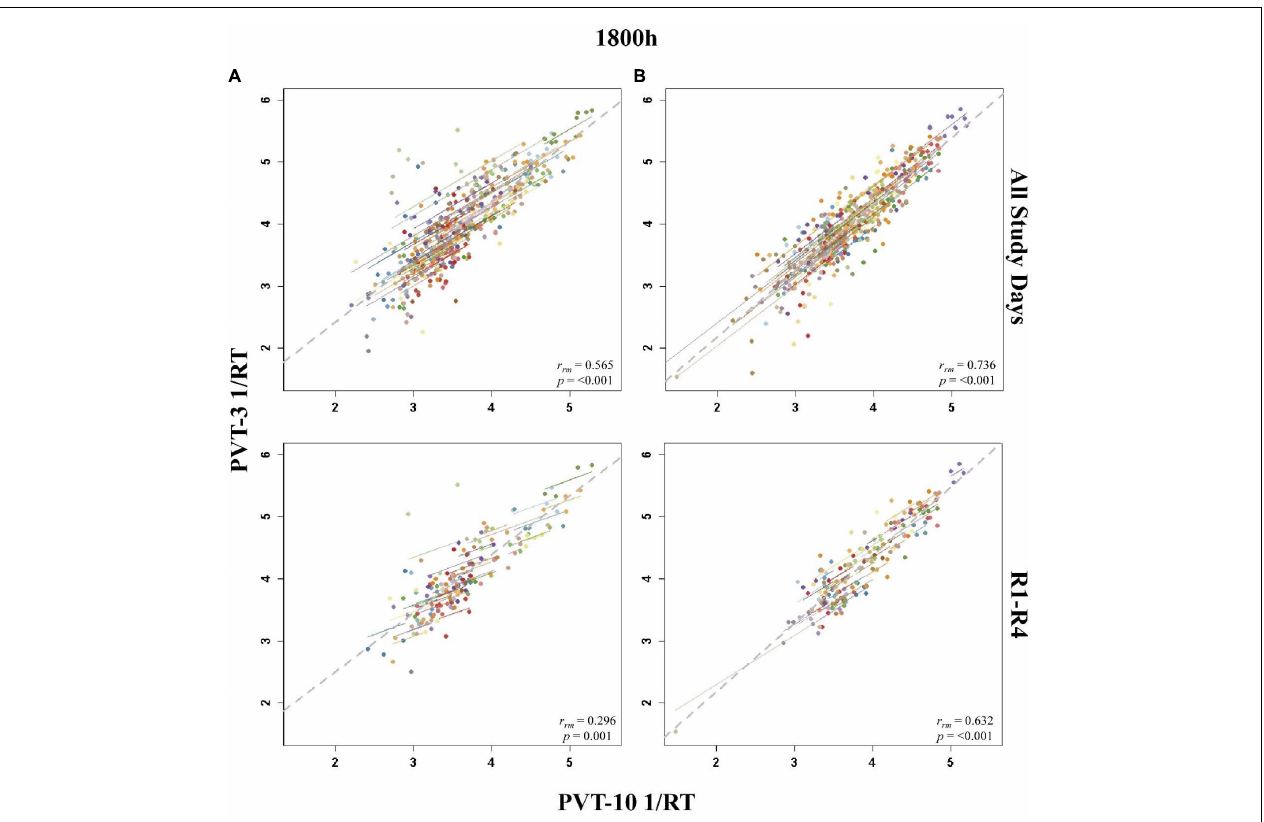
FIGURE 6 | Rmcorr plots of repeated-measures correlations between 10-min Psychomotor Vigilance Test (PVT-10) and 3-min Psychomotor Vigilance Test (PVT-3) response speed (1/RT) at 1800 h across the entire study (All Study Days) and across only recovery days 1–4 (R1-R4) for Condition A (A) and Condition B (B) . Each color represents a distinct participant with each point showing performance on both measures at one time point while the corresponding line shows the rmcorr fit for that participant (Bakdash and Marusich, 2020; R Core Team, 2020). The gray dashed line represents the regression line obtained by ignoring repeated measurements and treating the data as independent observations; r rm represents the common within-individual association (rmcorr). Rmcorr effect sizes were interpreted as follows: 0.00–0.29, negligible; 0.30–0.49, weak; 0.50–0.69, moderate; 0.70–0.89, strong; and 0.90–1.00, very